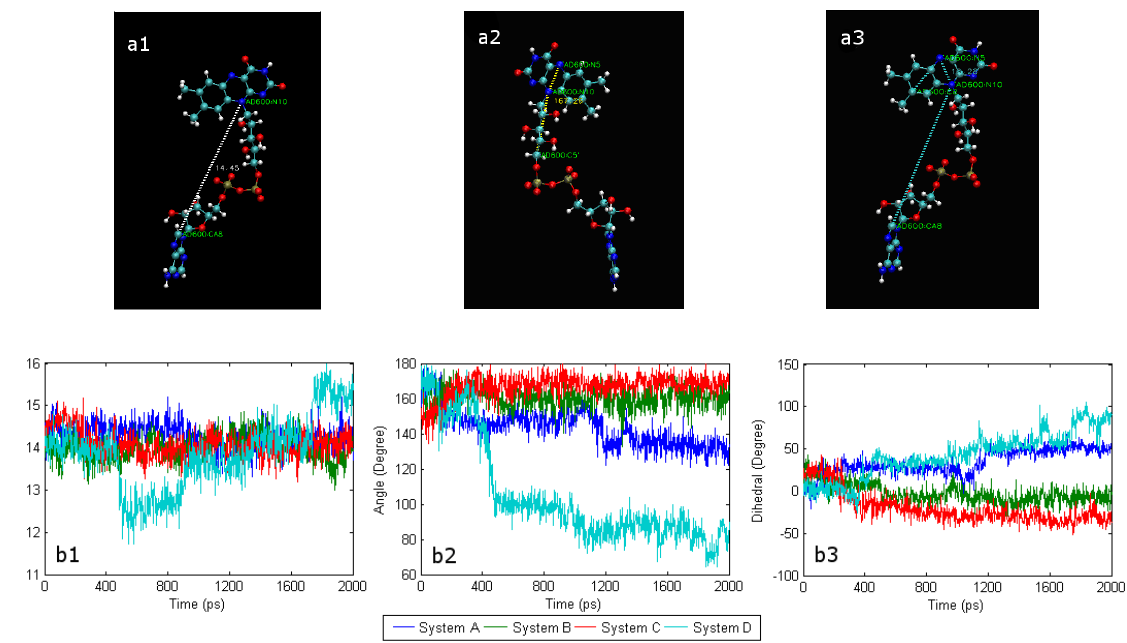
Figure 2. (a1) Distance (N10-CA8) represents the distance between the isoalloxazine and the adenine of FAD; (a2) Angle (N5-N10-C5') represents the bending deflection of the virtual axis (N5-N10) of isoalloxazine relative to the virtual axis (N10-C5') of the ribitol segment; (a3) Dihedral angle (C8-N5-N10-CA8) reflects the degree of rotation of the isoalloxazine plane about the virtual axis (N5=N10); (b1) Trends for the distance (C8- CA8), (b2) trends for the angle (N5-N10-C5') and (b3) trends for the dihedral angles (C8-